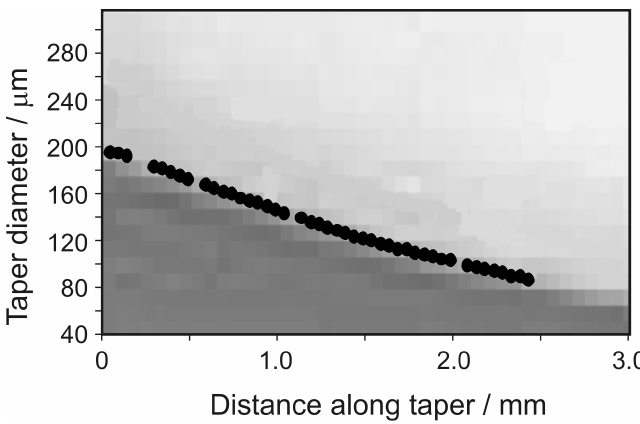
Figure 5. Measurement of the geometrical profile of a tapered optical fibre from the spacing between WGMs measured at a series of positions along the taper. The profile extracted from the spectra is overlaid with a microscopic image of the